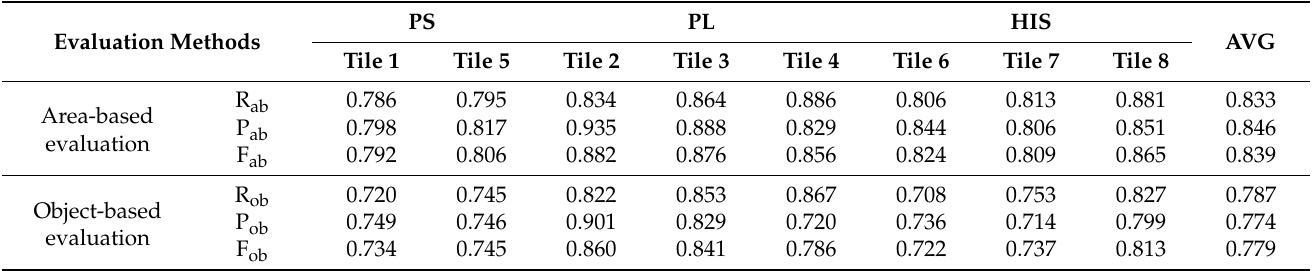
Table 3. Evaluation of the area- and object-based accuracy of the cropland parcel extraction results. PS, PL, and HIS indicate three different agricultural landscape types, i.e., plain areas with large cropland parcels, plain areas with small cropland parcels, and hilly areas with irregularly shaped cropland parcels, that were described in Section 2.3.